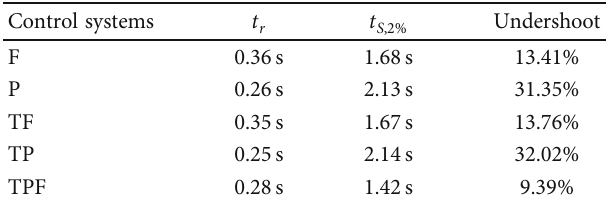
Table 3: Results of di ff erent control systems recovering from a 1m disturbed altitude